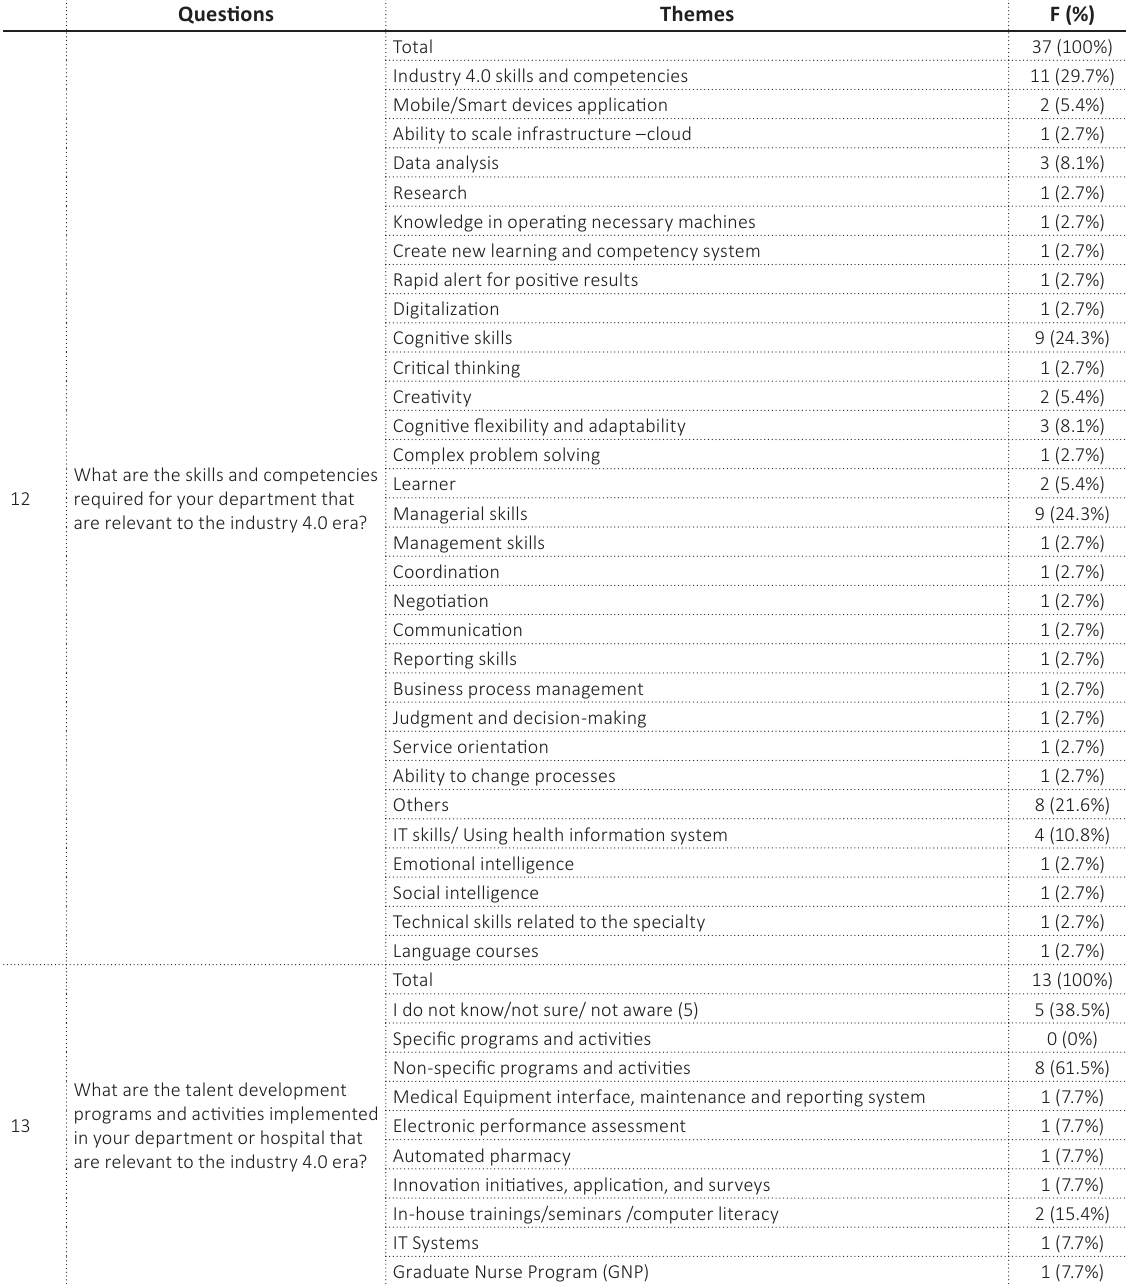
Table A1 (cont.). Thematic analysis of the survey’s